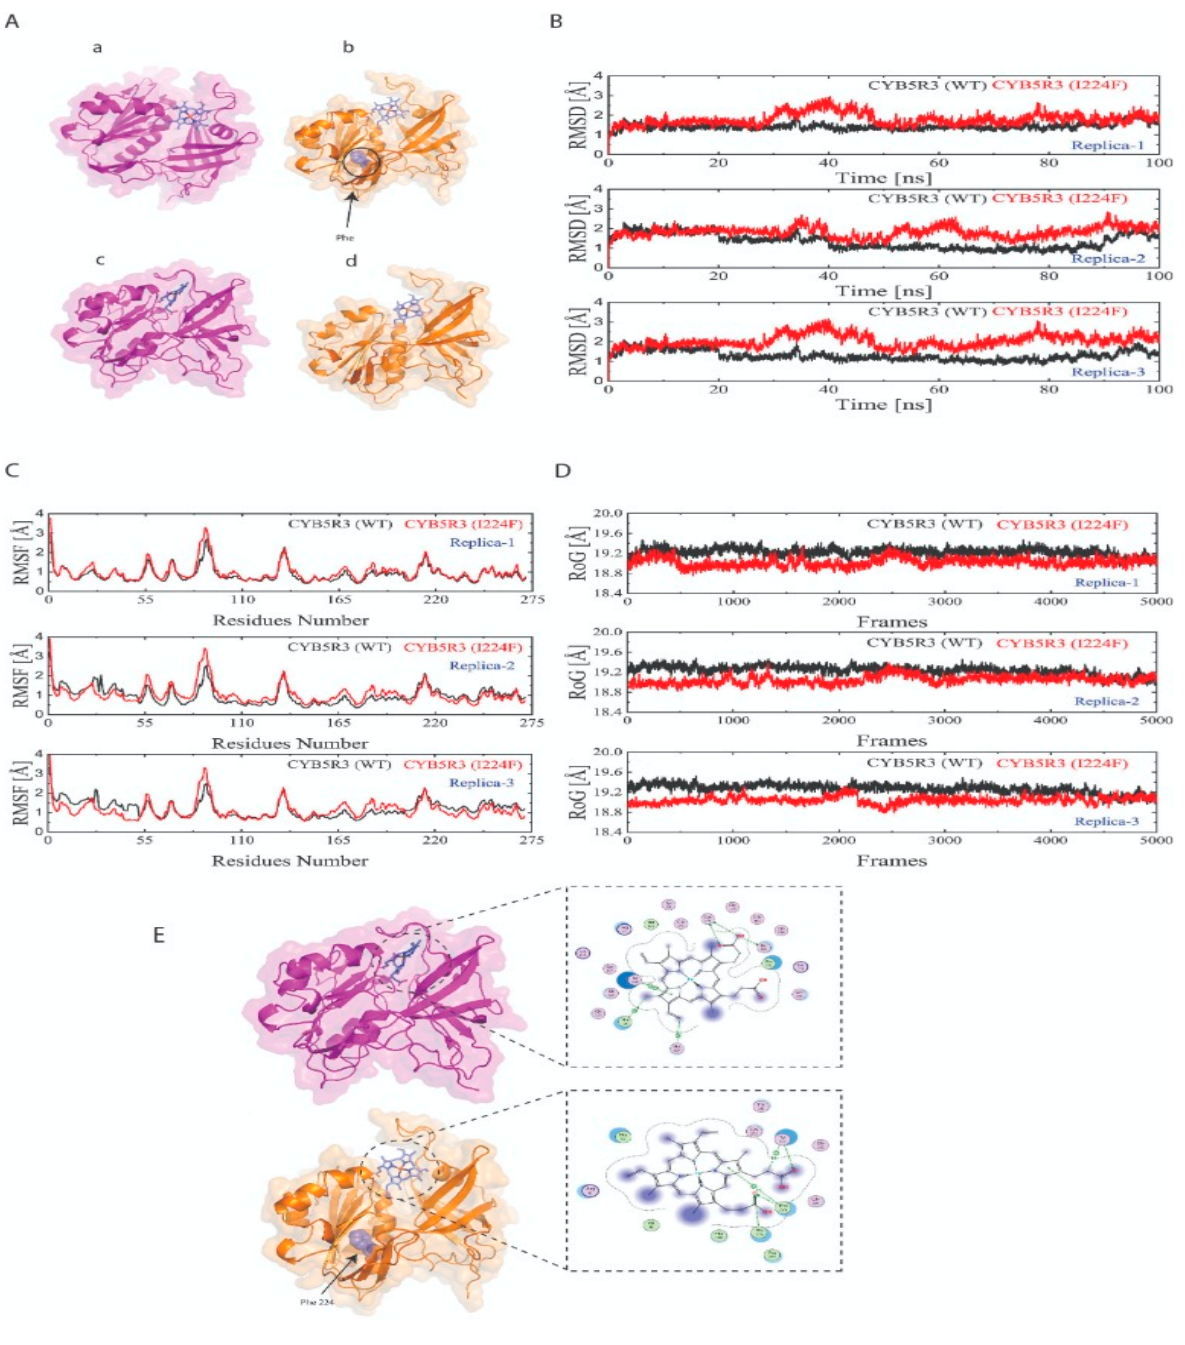
Figure 2. CYB5R3 before (a,b) and after (c,d) molecular dynamic simulations ( A ). Molecular dynamics simulation of the CYB5R3 WT (black curve) and MT (red curve) generated over 100 ns in triplicate showing the root mean square deviation (RMSD) ( B ); root mean square fluctuation (residual fluctuations over the simulation time) ( C ); radius of gyration ( D ). Heme docking with the native and mutant CYB5R3 showing potential interactions ( E ). Heme established a significant number of hydrogen bond donor and acceptor inter- actions with the binding site residues of native CYB5R3. It was observed that in the case